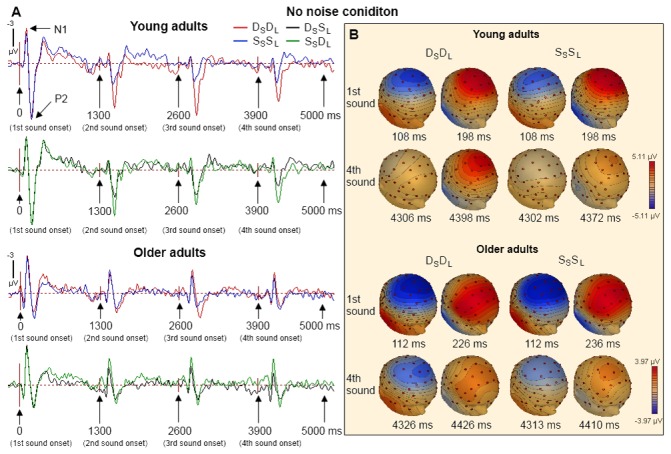
ERP waves elicited by four consecutive sound stimuli in the DSDL, DSSL, SSDL and SSSL trials in the no noise condition.(A) Evoked responses averaged for young and older adults at Cz in the DSDL, DSSL, SSDL and SSSL trials. (B) The topographic maps of the N1 and P2 waves at latencies showing peak ERP amplitudes at Cz for the 1st and 4th sound in the DSDL, and SSSL trials among young and older adults.